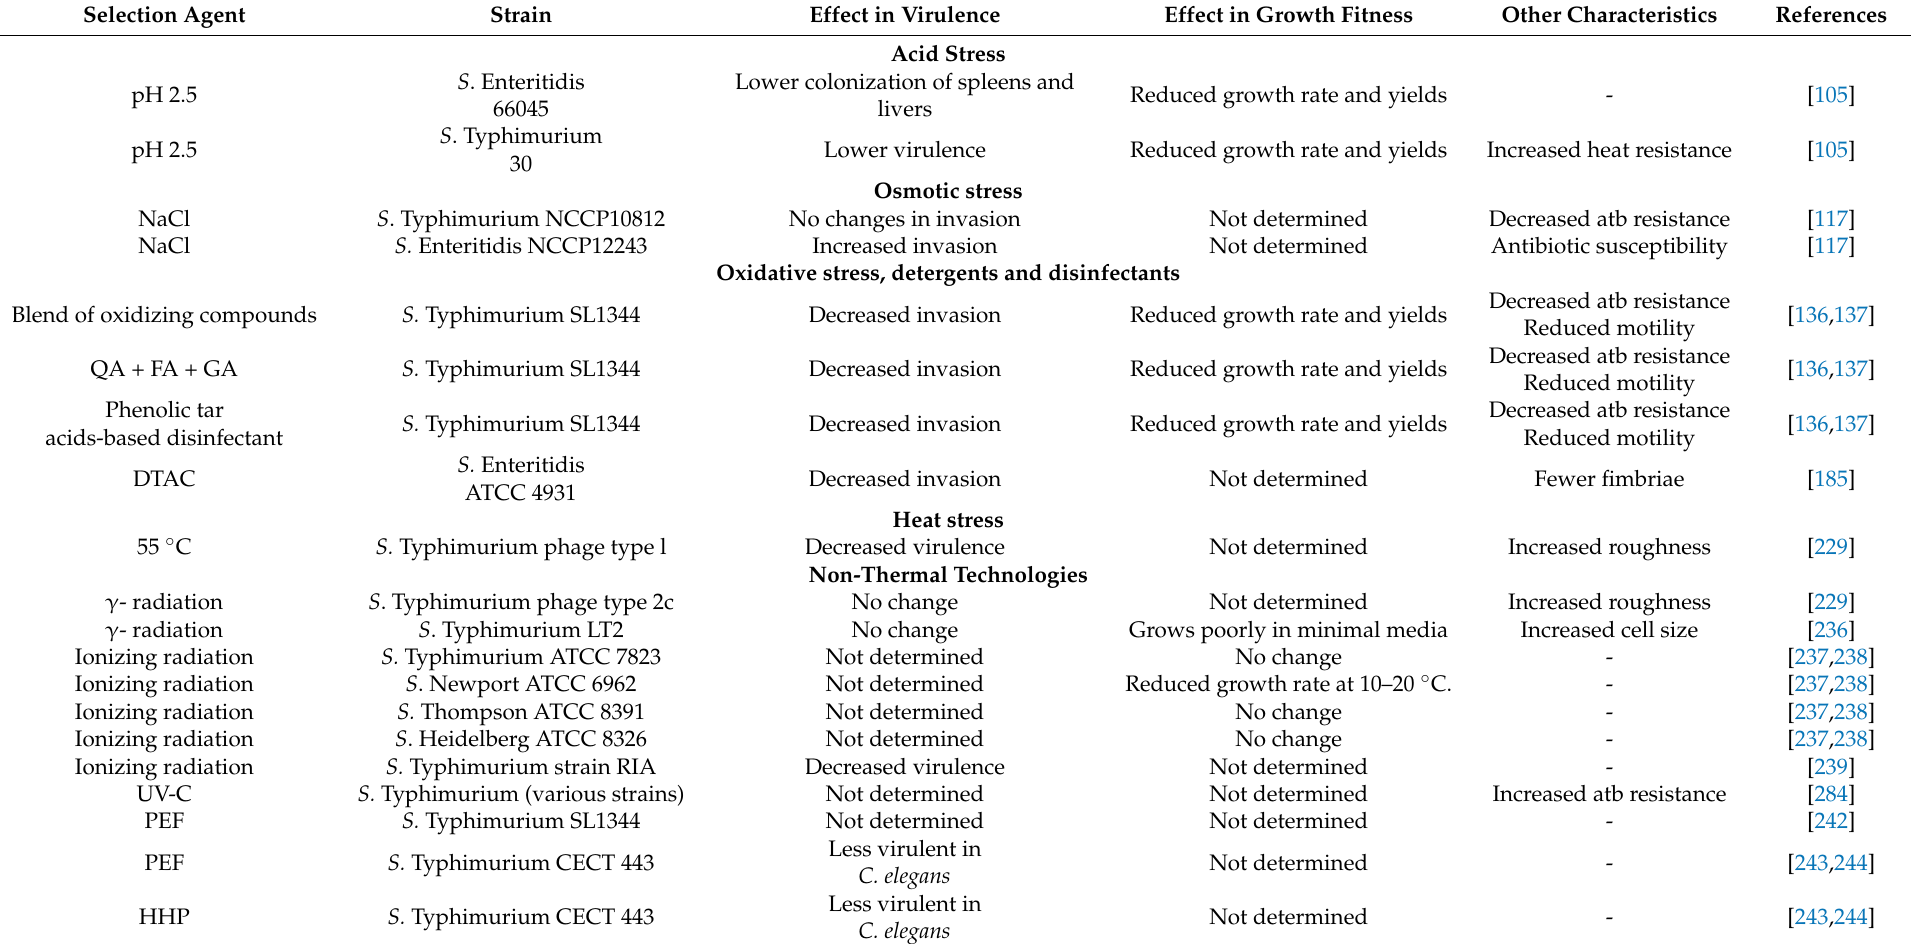
Table 1. Examples of stable Salmonella variants obtained after successive exposure to different selecting agents: impact on virulence, growth fitness and other phenotypical characteristics. Selection